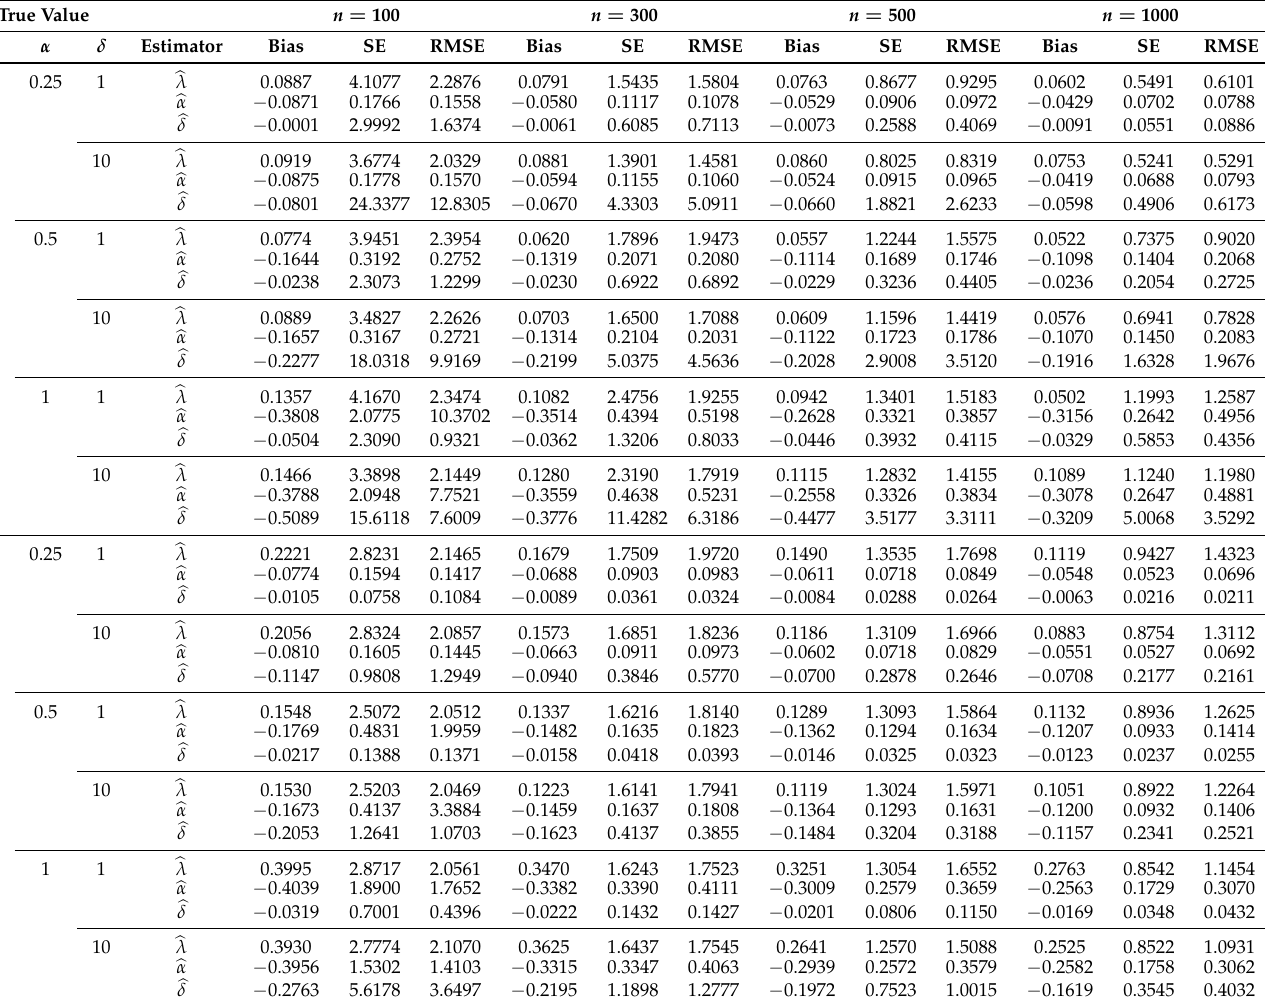
Table 1. Estimated bias, SE and RMSE for ML estimators in finite samples from the EHSN